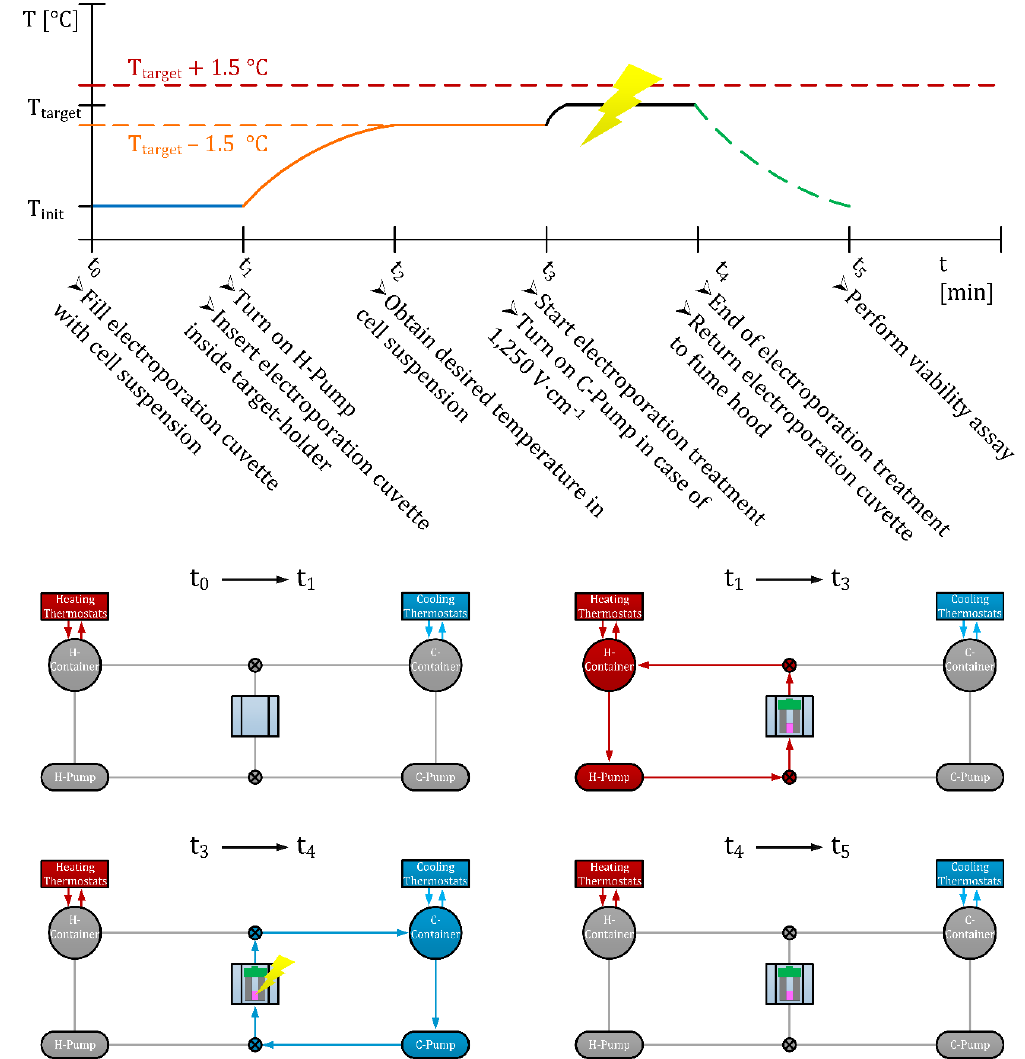
Figure 4. Time scheme of the application of HyCHEED in vitro. Please note that the red and orange dotted lines represent the temperature fluctuations around T target . Also note that at t 3 H-Pump was switched to C-Pump when 1,250 V ⋅ cm −1 was used.